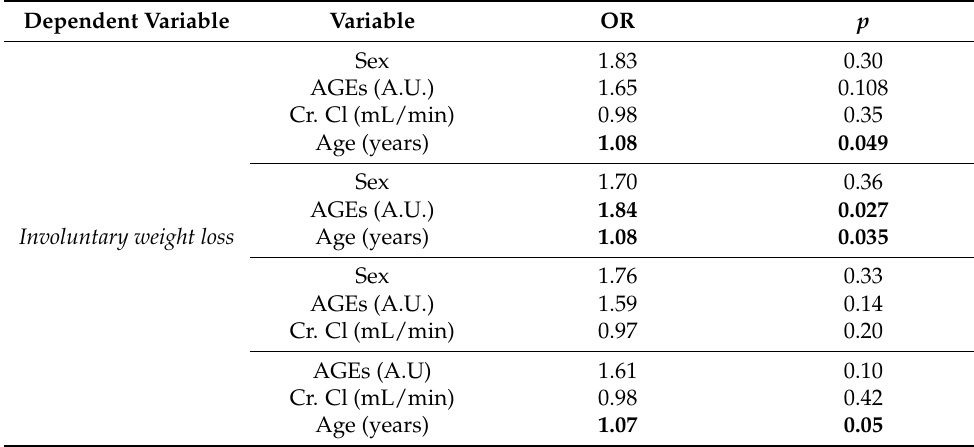
Table 4. Multivariate logistic regression analysis of the association between AGEs and involuntary weight loss weighted for sex, age and creatinine clearance.